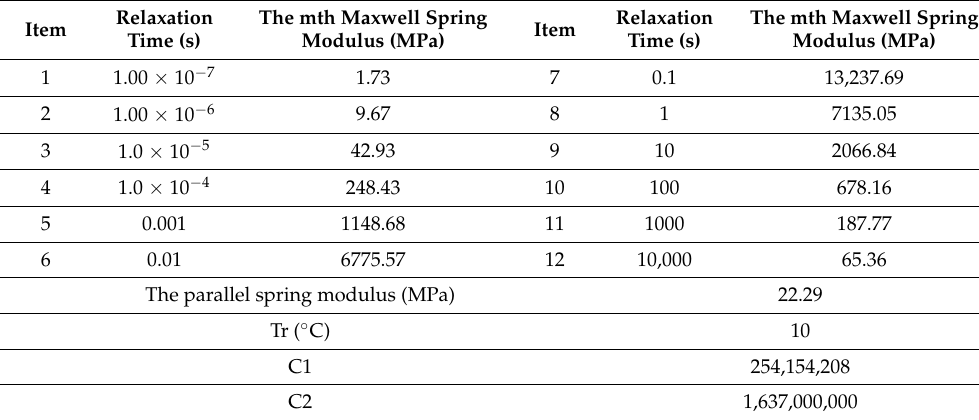
Table 5. Prony series data of the asphalt base